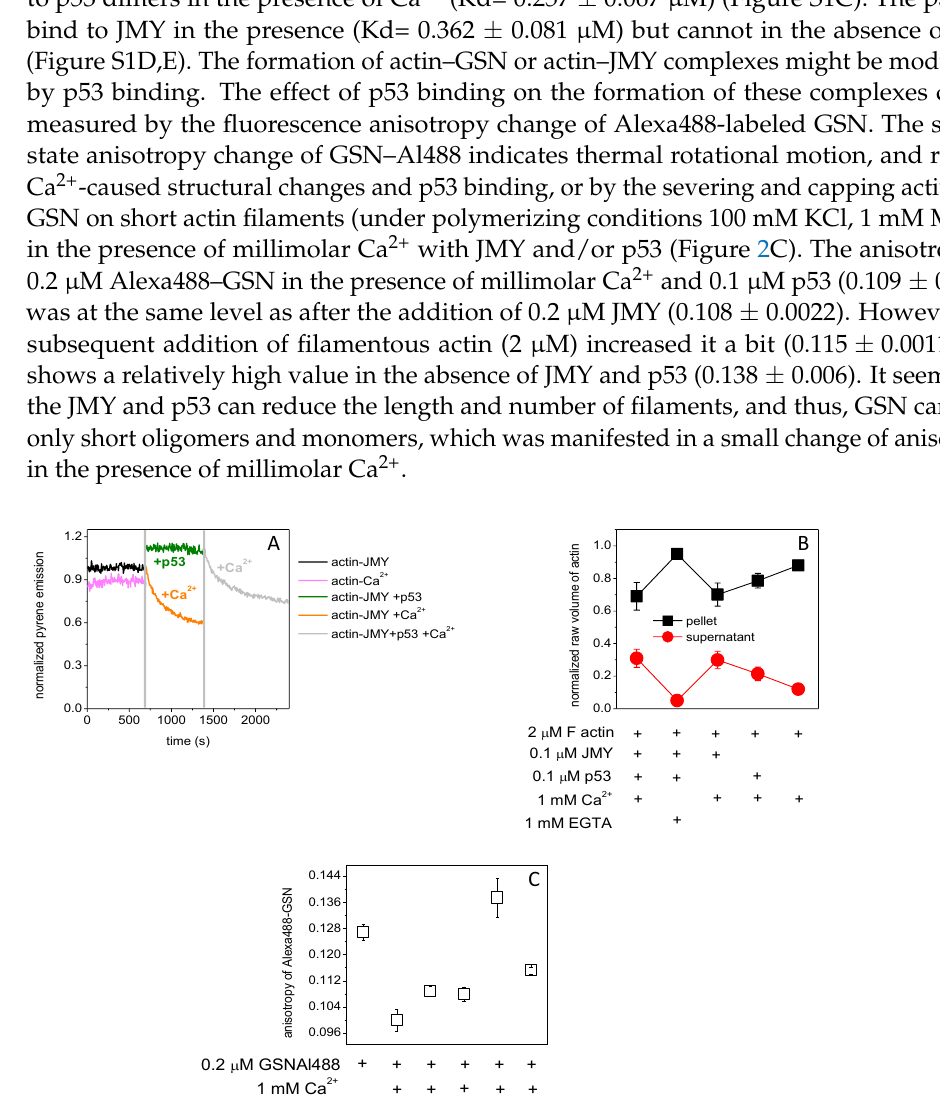
Figure 2. JMY reorders actin filaments. ( A ) The pyrene–actin (2 µ M, 5% labeled by pyrene) was polymerized (by 0.1 mM EGTA, 100 mM KCl, 1 mM MgCl 2 ) in the presence of JMY (0.1 µ M) (black line). The pyrene emission was increased by p53 (0.1 µ M) (green line) and then subsequently decreased by 1 mM Ca 2+ addition (gray line). In the absence of p53, JMY–actin shows a bit higher sensitivity to millimolar Ca 2+ (orange line), while in the absence of JMY and p53, it was less sensitive to Ca 2+ (pink line). ( B ) The analysis of filamentous actin co-sedimentation (2 µ M) with p53 and/or JMY (by SDS-PAGE Suppl. 1A) shows a big loss of actin which went from the pellet to the supernatant in the presence of 1 mM Ca 2+ and 0.1 µ M JMY, independently of p53. ( C ) The fluorescence anisotropy of Alexa488-labeled GSN (0.2 µ M) under polymerizing conditions (100 mM KCl, 1 mM MgCl 2 ) in the presence of millimolar Ca 2+ with p53 (0.1 µ M) was not changed by JMY (0.2 µ M). The anisotropy was increased by 28% by filamentous actin (2 µ M) in the absence of p53 and increased by only 8% in the presence of p53, JMY and filamentous actin. The data presented were derived from at least three independent experiments. Values are displayed as the mean ± standard